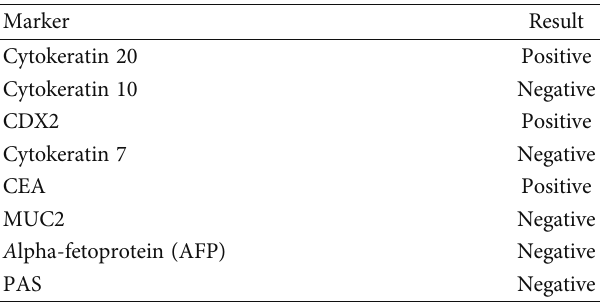
Table 1: Summary of the tumor ’ s immunohistochemistry report.